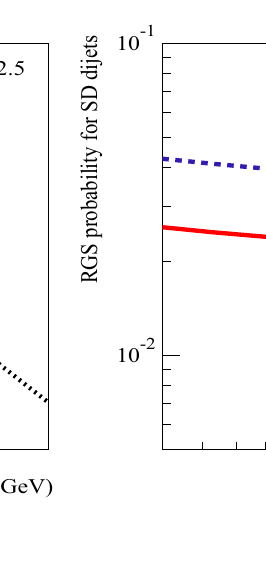
/ S 2 changing from 0.65 SD ( tot ) SD ( eik )